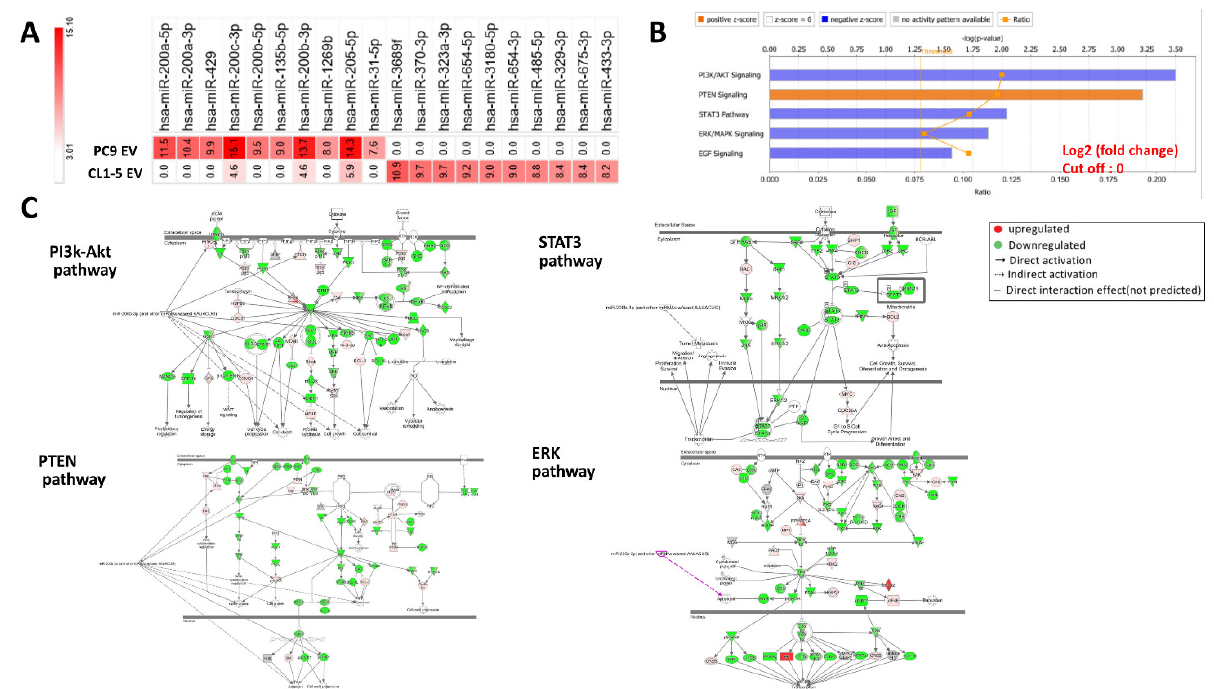
Figure 5. Different micro-RNA expression profiles between EVs from EGFR-mutant cells and EVs from EGFR wild-type cells and associated regulatory signal pathway. ( A ) Differential miRNA expression in EVs from PC9 cells compared to those from CL1-5 cells. ( B ) A miRNA regulatory signal network analysis was performed using ingenuity pathway analysis (IPA) software. ( C ) This gene network displayed the top ranked network found associated with the mi200. Red and green tags represent the upregulated and downregulated genes, respectively.